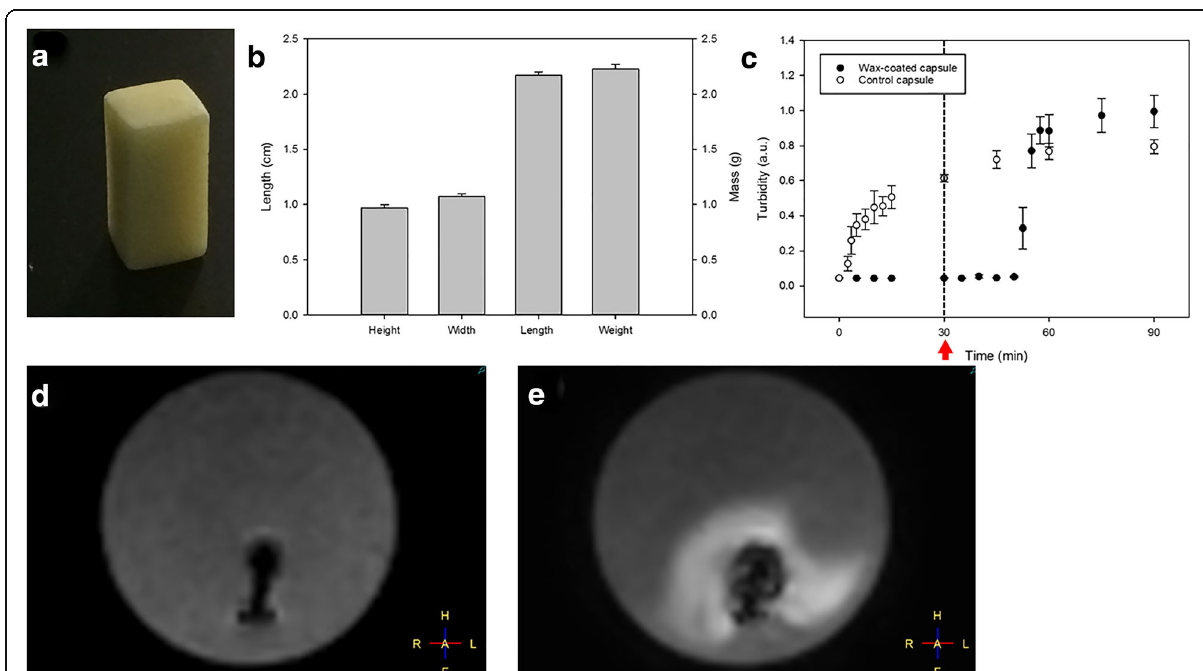
Fig. 3 Morphology, dimensions, and release kinetics of lanolin/cetyl alcohol-coated capsules. Wax-coated capsules were made using the Michelangelo method, in which the capsule is carved out of a wax layer, exhibited highly reproducible dimensions and weight ( n = 6, a , b ). The wax-coated capsules were incubated in phosphate buffer at pH6.8 for 30min at 37°C. The non-coated hydroxypropyl methylcellulose capsules released their content almost immediately while the wax-coated capsules remained intact ( n =3, c ). After 30min, the temperature was increased to 43°C, and after a short delay, the wax-coated capsules released their cargo ( n =3, c ). The red arrow indicates the time point when the temperature increase was started. The release kinetics of the uncoated capsules containing freeze-dried gadoterate was further assessed using T1-weighted MRI. One minute after exposing the capsule to water, the capsule was visible as a T1-hypointense signal ( n =3, d ). After 20min, the hypointense capsule was surrounded by a strong T1-hyperintense signal ( n = 3, e ), stemming from the hydration of lyophilised gadoterate after capsule disintegration. All results are shown as mean ± standard